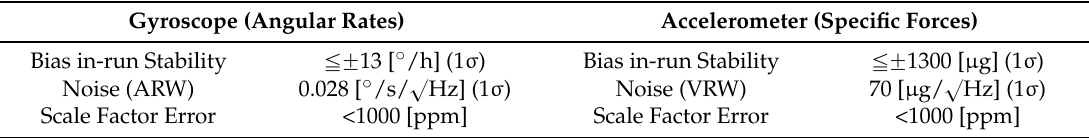
Table 1. Error characteristics of the simulated MEMS-IMU.